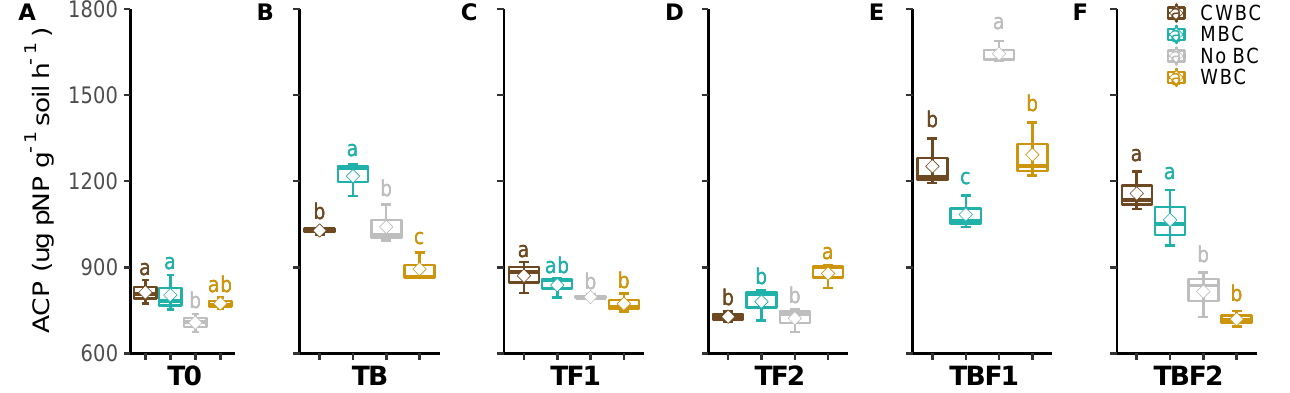
Figure 5. Effect of microbial inoculants on the soil acidic phosphomonoesterase activity after biochar application. Treatment abbreviations—see Figure 1. Quantiles are shown at the top and bottom of the box. Max and min values are indicated by the bars. The lines within the box indicate the median values. The transparent dot indicates the observation value. Letters above the bars indicate the significance level at p < 0.05 by LSD.